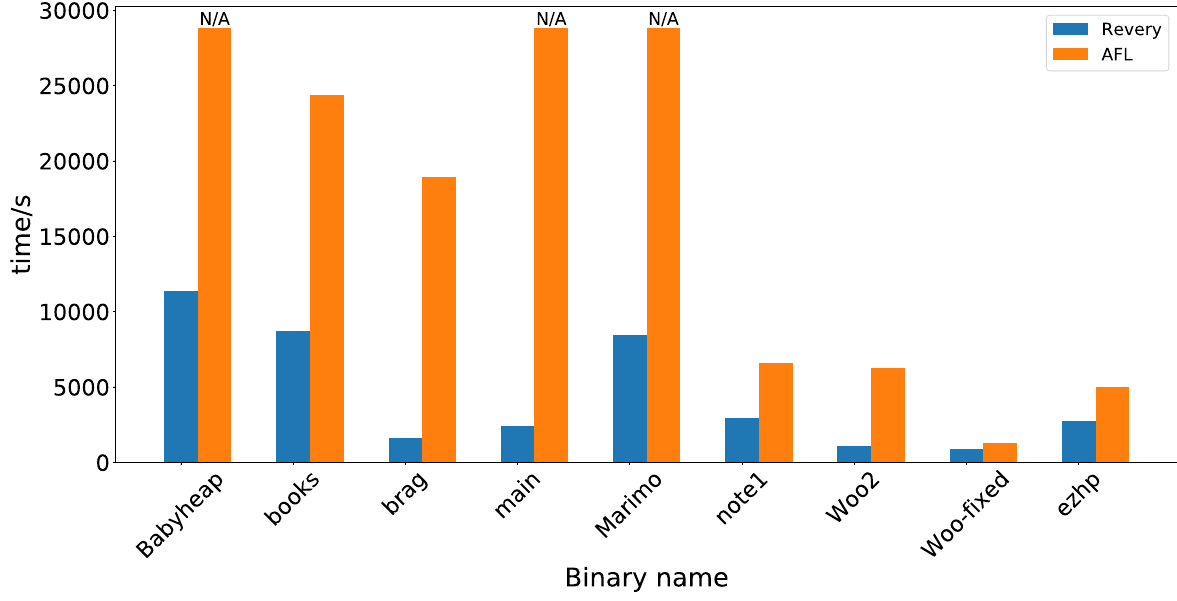
Fig. 11 Time interval for finding exploitable states in diverging path by Revery , comparing to AFL